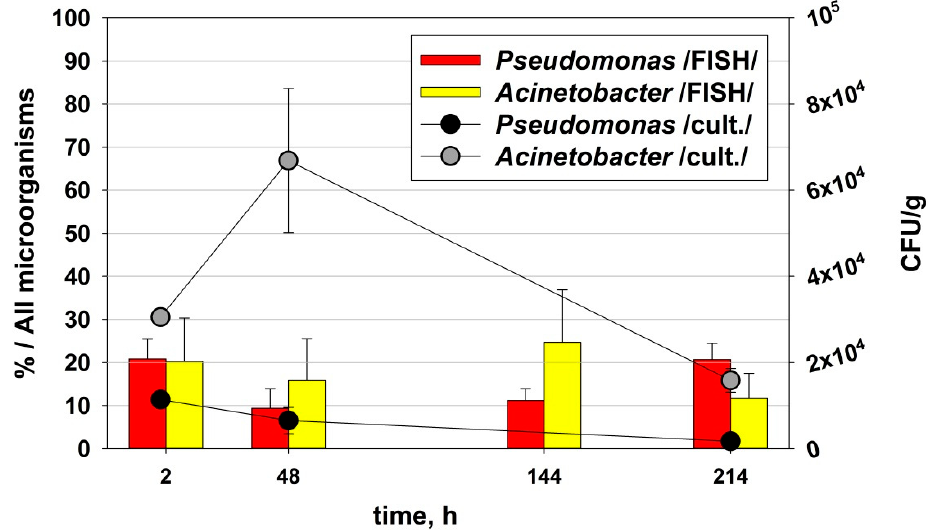
Figure 9. Comparison between culturable and non ‐ culturable bacteria of the genus Pseudomonas and the genus Acinetobacter in the variant PhND. the genus Acinetobacter in the variant